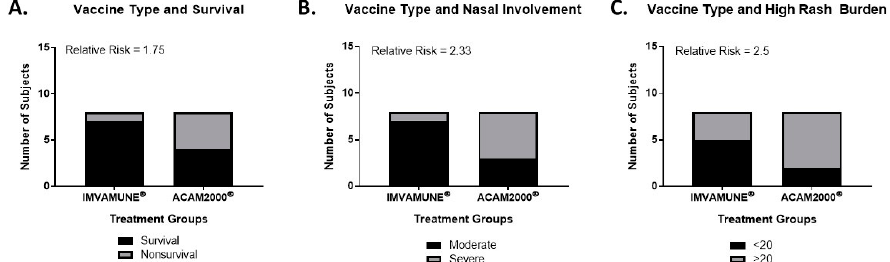
Figure 9. Relative risk analysis. In animals challenged with 2 × LD 50 MPXV dose, the relative risk of survival ( A ) and mitigation of primary ( B ) and secondary lesions ( C ) are shown for IMVAMUNE ® (left) and ACAM2000 ® (right) vaccination. No di ff erences between the vaccines reached significance by Fisher’s exact